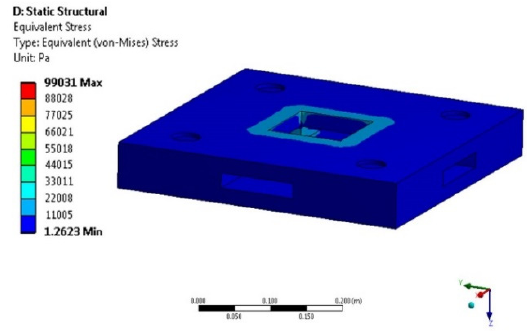
Figure 7. Von-Mises stress for initial geometry. Table 2. Equivalent stress and maximum deformation for monocoque model.